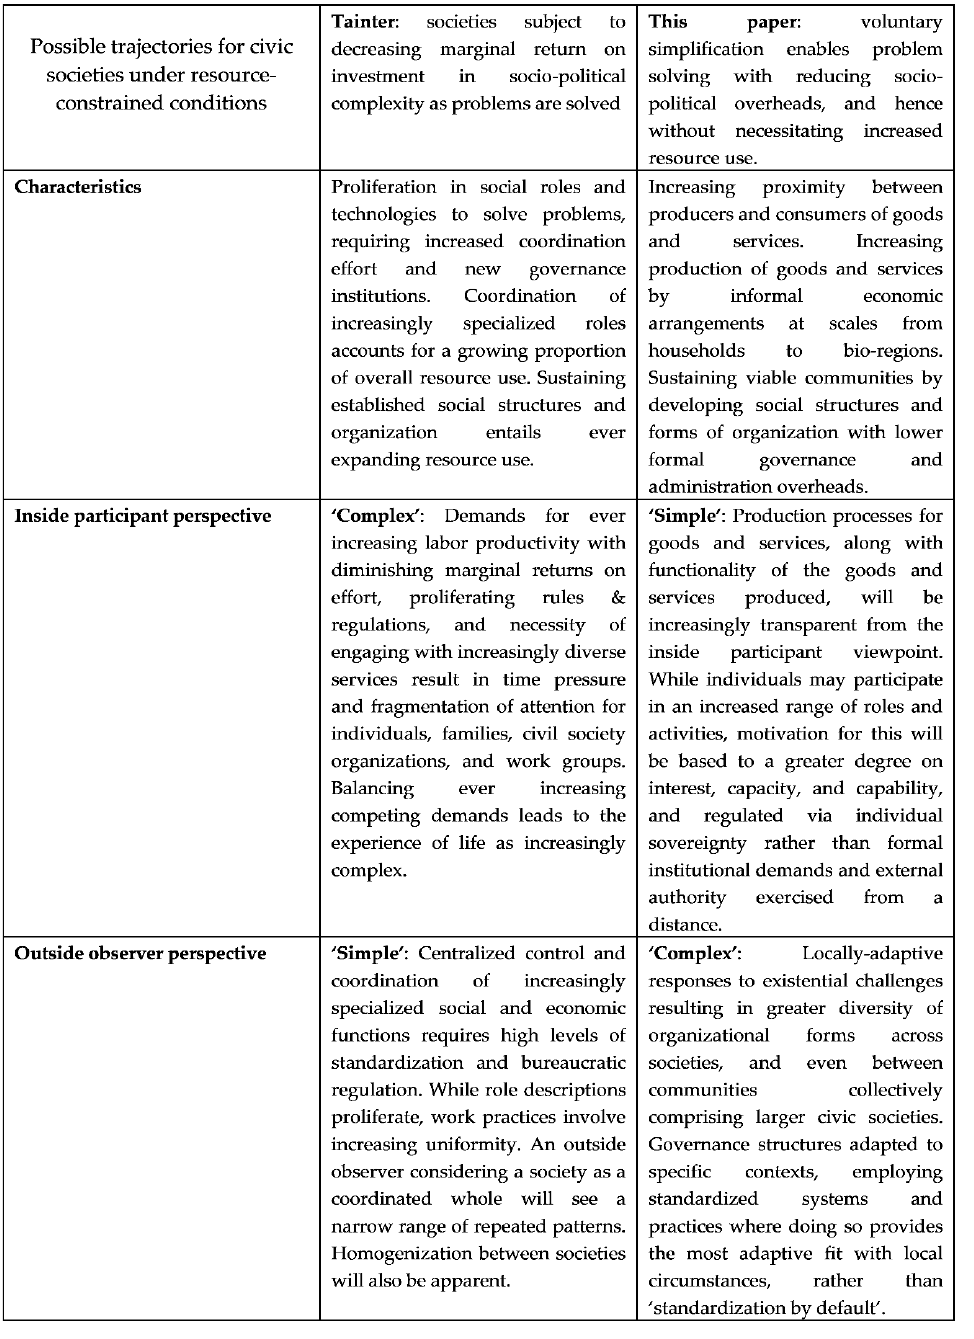
Figure 1. How the experience of different forms of social organization as ‘complex’ or ‘simple’ varies between participant and external observer perspectives.